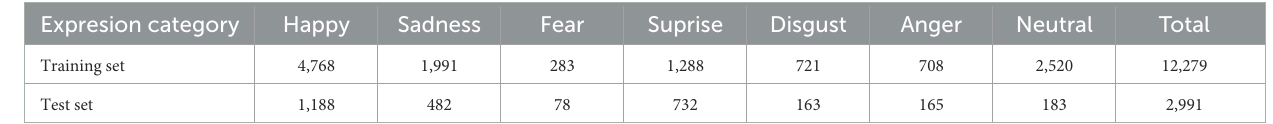
TABLE 3 Distribution of expression categories in the RAF-DB dataset.